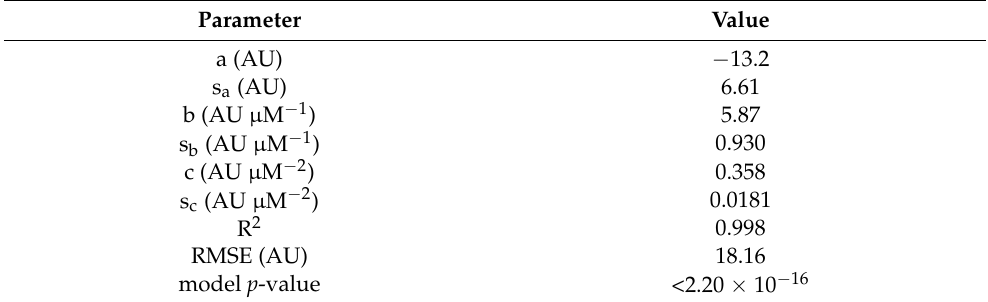
Table 3. Parabolic regression parameters. All values are reported with the corresponding measure unit, AU stands for (FLD) area unit. RMSE stands for root mean squared error.